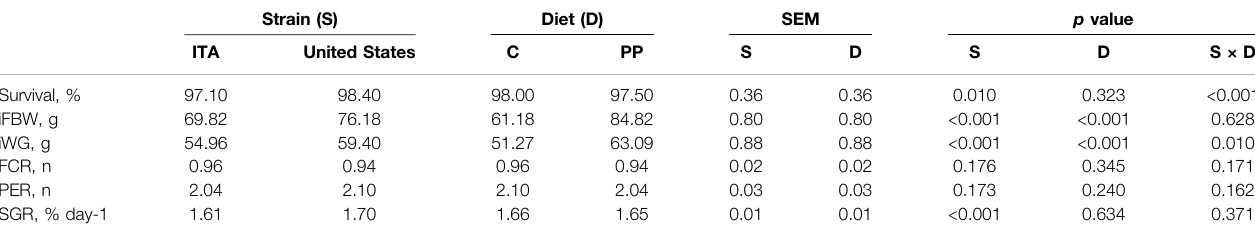
TABLE 2 | Growth performance of the rainbow trout depending on strain, diet, and their interaction ( n = 5). Strain (S) Diet (D) SEM ITA